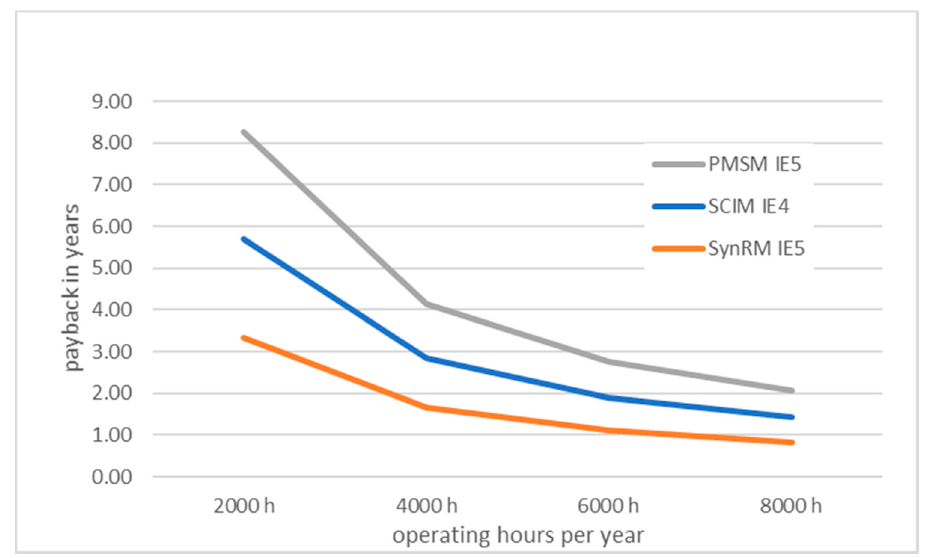
Figure 13. Payback time for SCIM IE4, SynRM IE5, and PMSM IE5, in relation to SCIM IE3, for LP2.